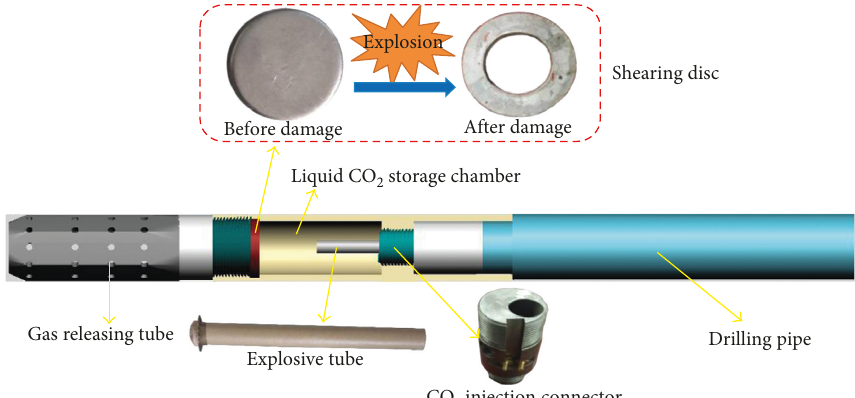
Figure 2: Explosive